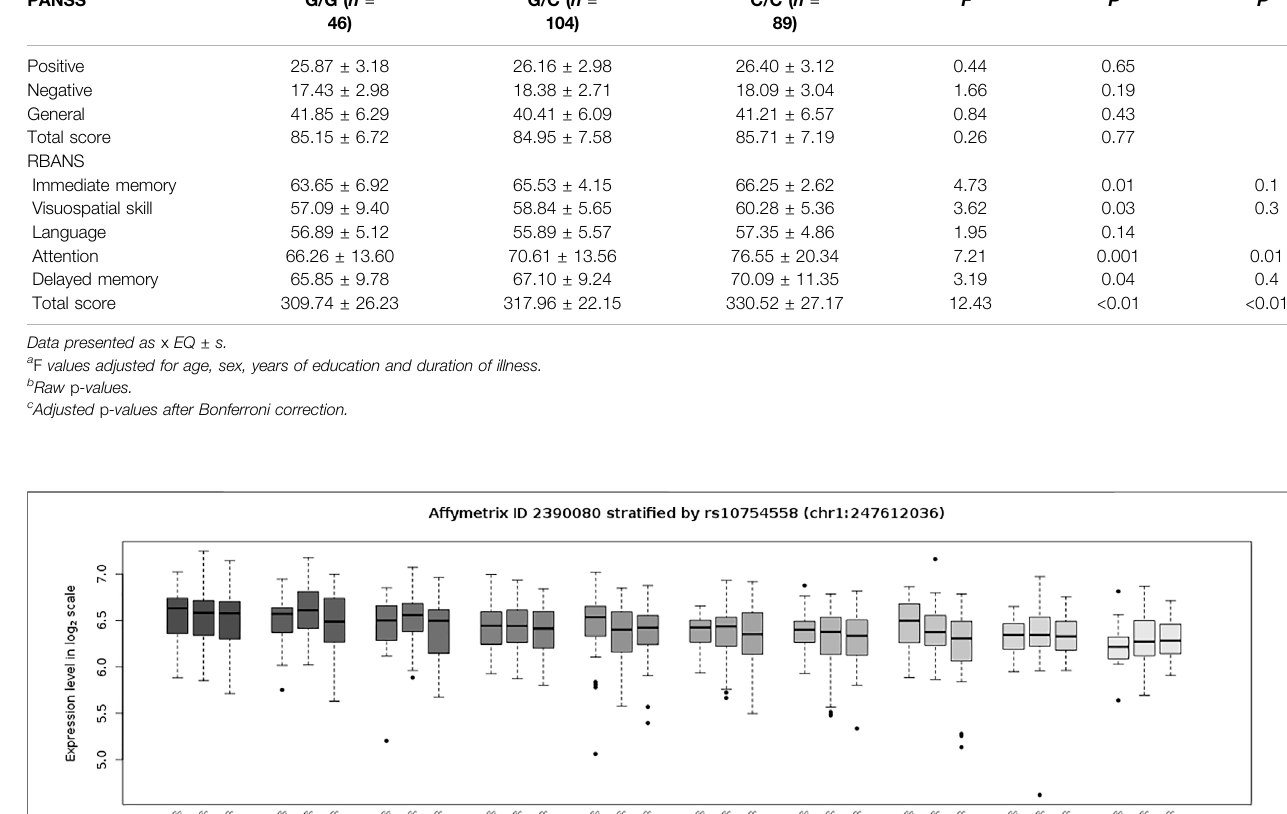
TABLE 2 | PANSS and RBANS performance comparisons of rs10754558 genotypic groups in patients with schizophrenia. PANSS